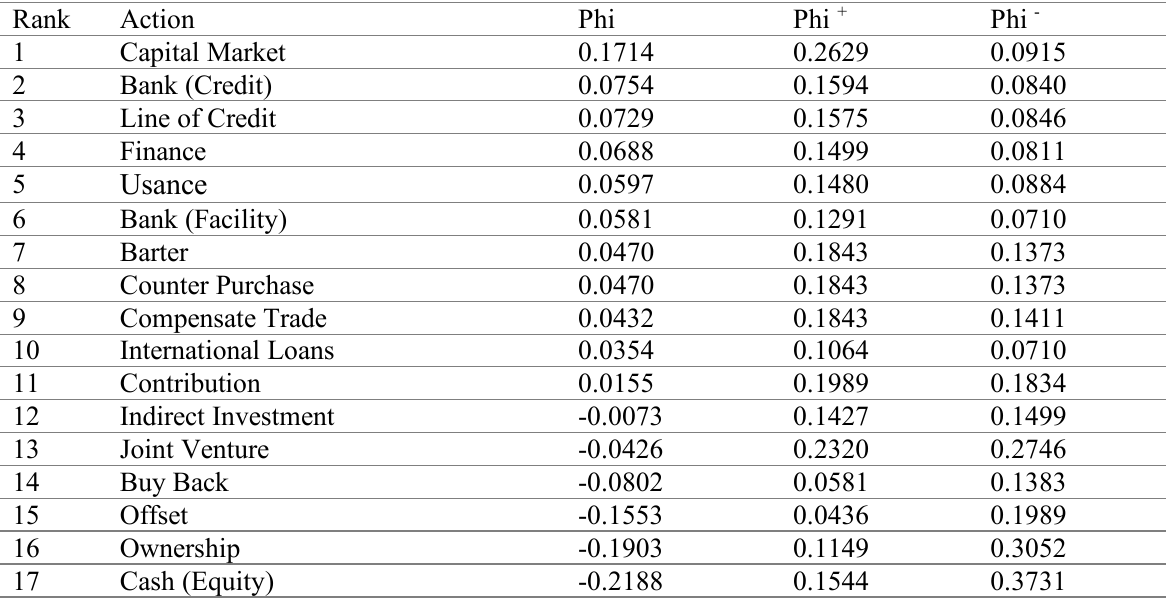
Table 4 . PROMETHEE